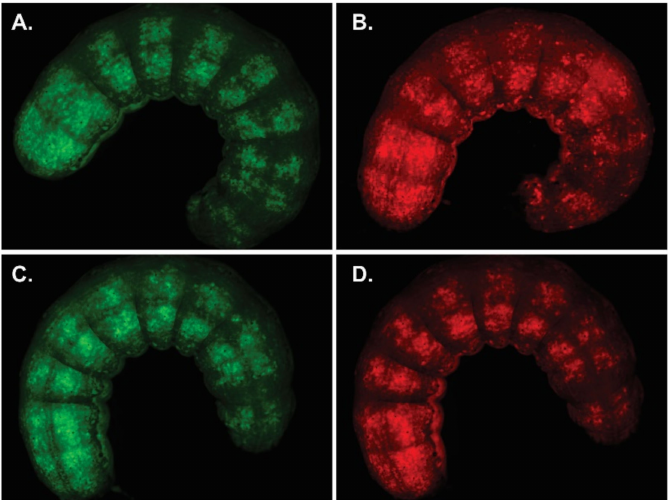
Figure 6. Infectivity of complemented AcMNPV p74 knockout. S. exigua larvae exposed to virions derived from AcMNPV knocked out in p74 and supplemented with the ORF variant of the same virus, AcMNPV-p74AcAc. ( A ) Representative larva after BV injection showing GFP and ( B ) mCherry expression. ( C ) Representative larva after per os infection with OBs showing GFP and ( D ) mCherry expression. All images (0.8 × ) were taken 120 h after starting